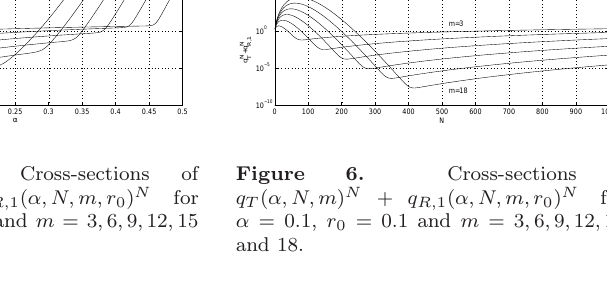
m=18m=3 m=18m=3 m=18m=3